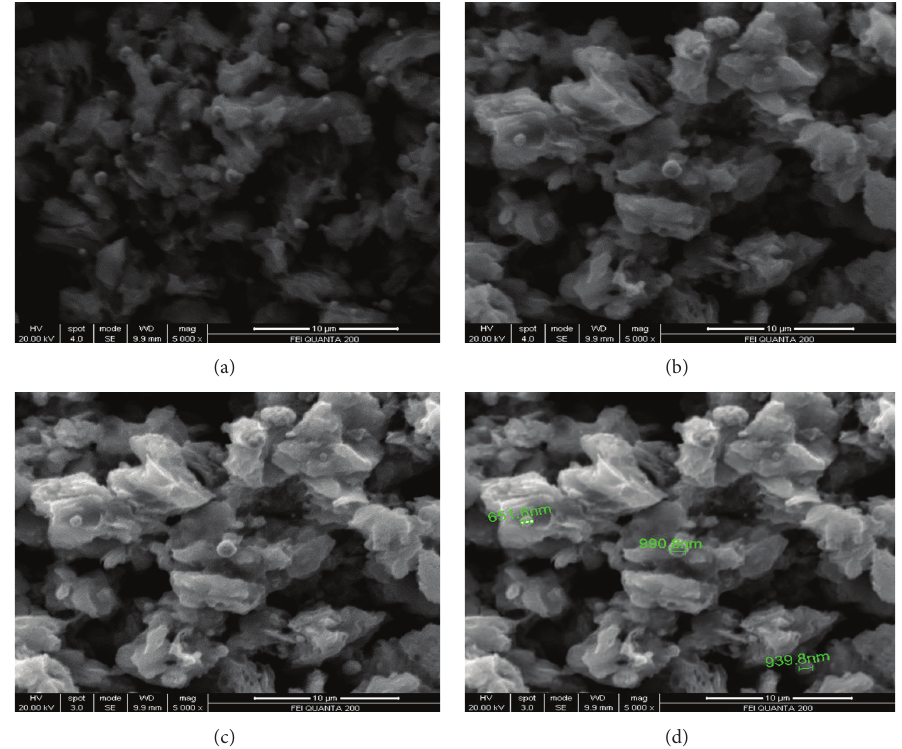
Figure 2: FE-SEM images of AuNPs-chi-graphene deposited on ITO substrates at various magnifications.